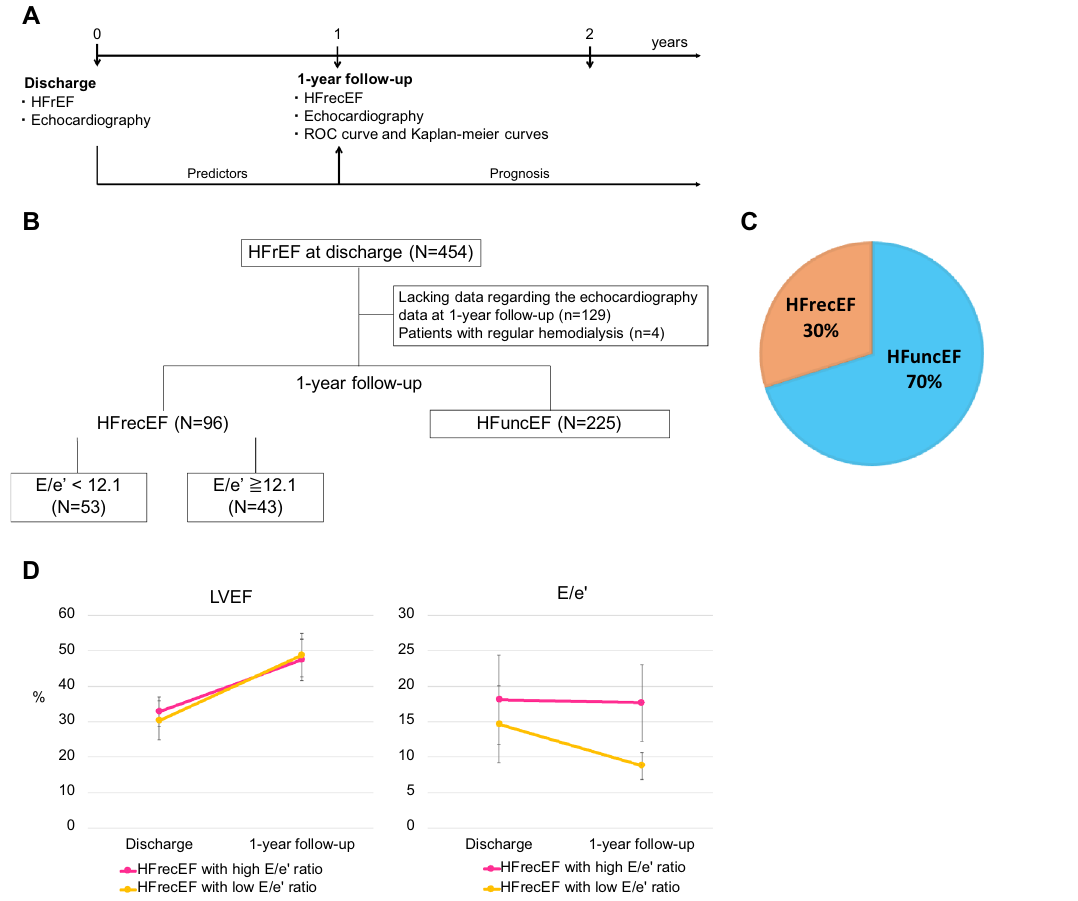
Figure 1. Study population. ( A ) Timeline. ( B ) Study flow chart. ( C ) Proportion of HFrecEF at the 1-year follow-up in patients with HFrEF. ( D ) Changes in LVEF and E/e ′ ratio in HFrecEF with low or high E/e ′ ratio group. E/e ′ peak velocity of the early wave (E) to early diastole (e ′ ), HF heart failure, HFrecEF heart failure with recovered ejection fraction, HFrEF heart failure with reduced ejection fraction, HFuncEF heart failure with unchanged ejection fraction, ROC receiver operating